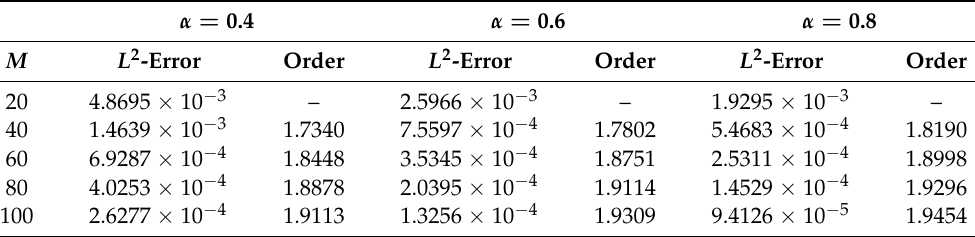
Table 6. The L 2 -norm errors and temporal convergence orders for Example 2 using scheme (48),